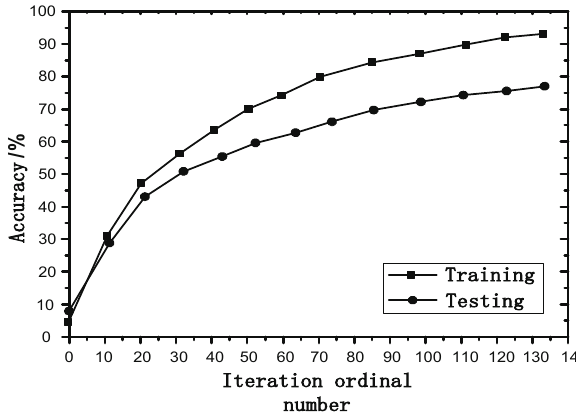
Figure 9: Accuracy curve of training and testing on the FER2013 dataset.